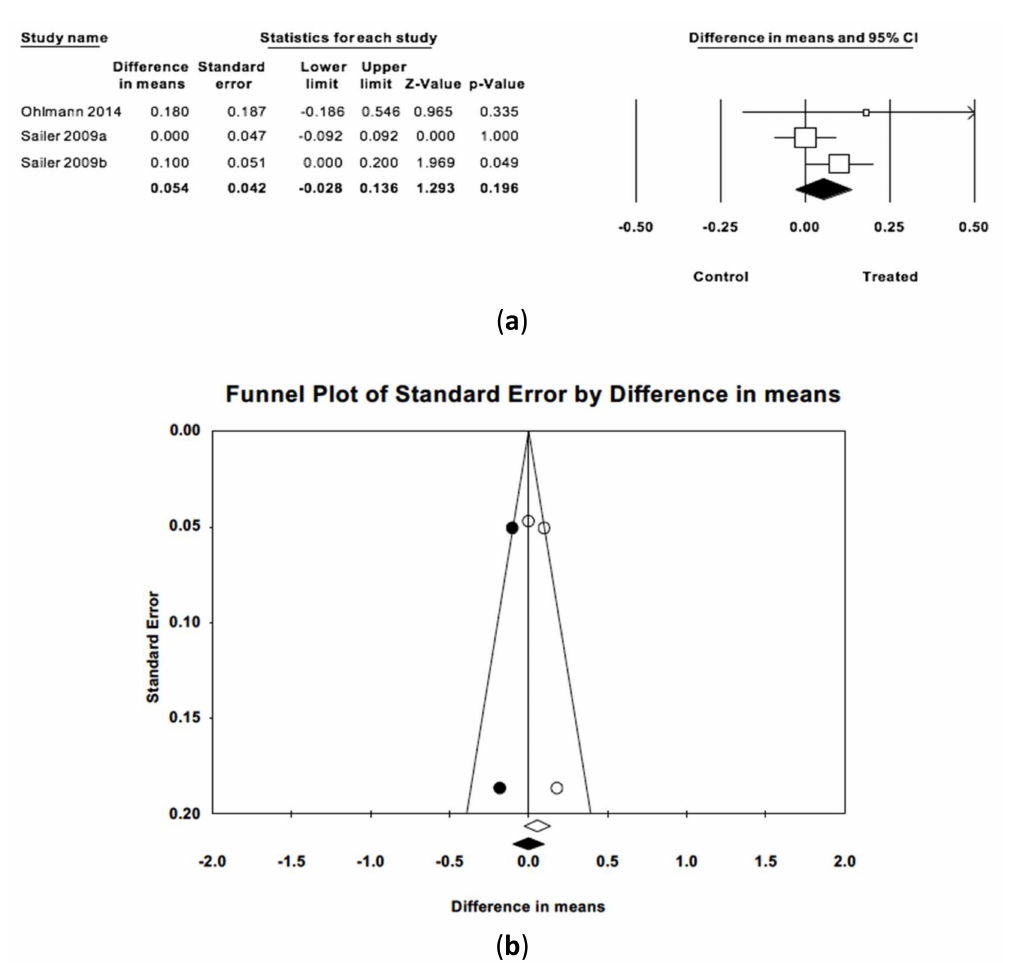
Figure 5. ( a ) Forest plot of meta-analysis of the di ff erence in mean gingival indices between treated and control groups. ( b ) Funnel plot with observed and imputed